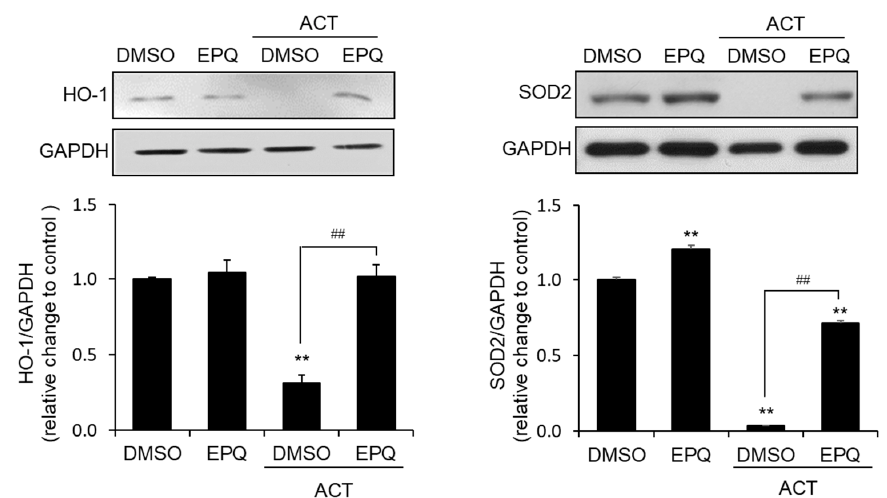
Figure 4. E ff ect of EPQ on acetaldehyde-induced oxidative stress-related enzymes in PC12 cells. Cells were treated with DMSO (0.5%, v / v ) or EPQ (20 µ M) in the presence and absence of acetaldehyde (500 µ M) for 24 h. The oxidative stress-related protein levels of HO-1 and SOD2 were determined by western blots. GAPDH was a loading control. All values are expressed as mean ± SEM ( n = 3; * p < 0.05, ** p < 0.01 compared to the DMSO control group and ## p < 0.01 compared to the group treated only with ACT). EPQ, ent -peniciherqueinone; DMSO, dimethyl sulfoxide; GAPDH, glyceraldehyde